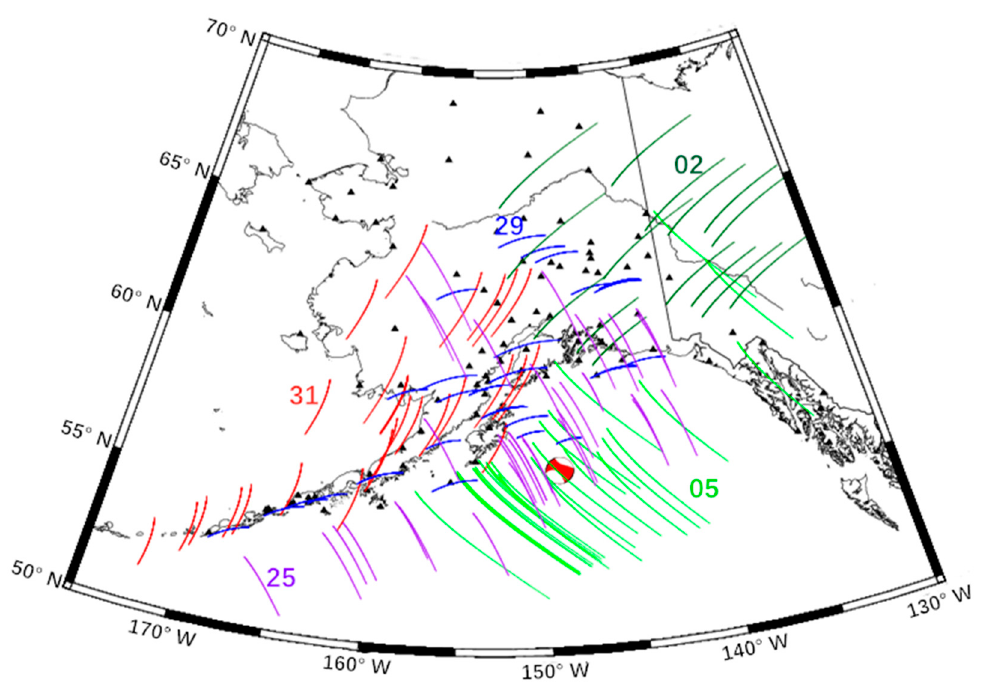
Figure 3. Sub-ionospheric points (SIPs) of the line of sight (LOS) between the stations and GPS satellites (02, 05, 25, 29, and 31) during 9:00–10:00 UTC.